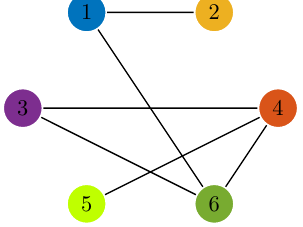
Figure 2. Communication